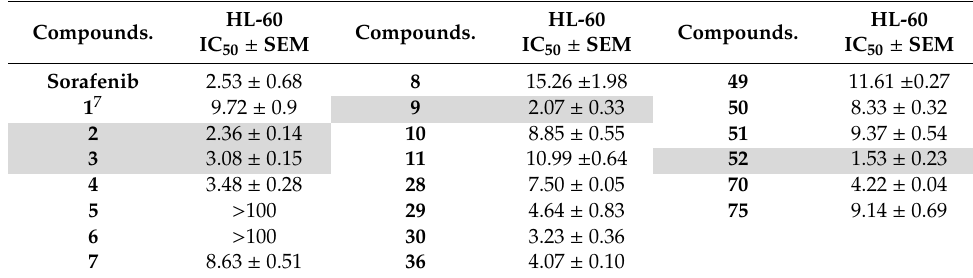
Table 1. E ff ect on the viability of HL-60 cells (IC 50 , µ M) of compounds 1 – 11 , 28 – 30 , 36 , 49 – 52 , 70 , 75 and sorafenib with alamarBlue ®